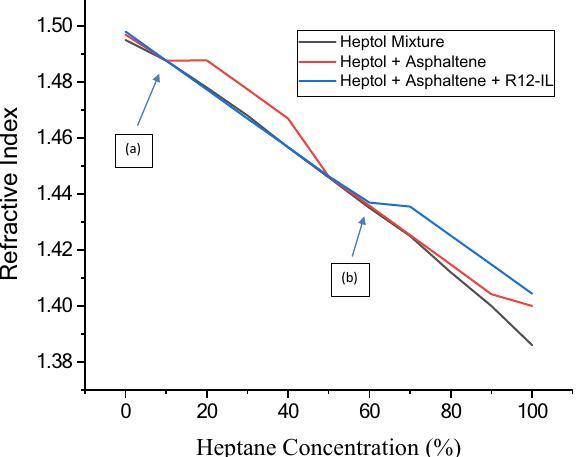
Figure 8. Asphaltene onset precipitation using the refractive index technique, where ( a ) represents the asphaltene onset precipitation in heptol solution, and ( b ) represents the asphaltene onset precipitation in the presence of R 12